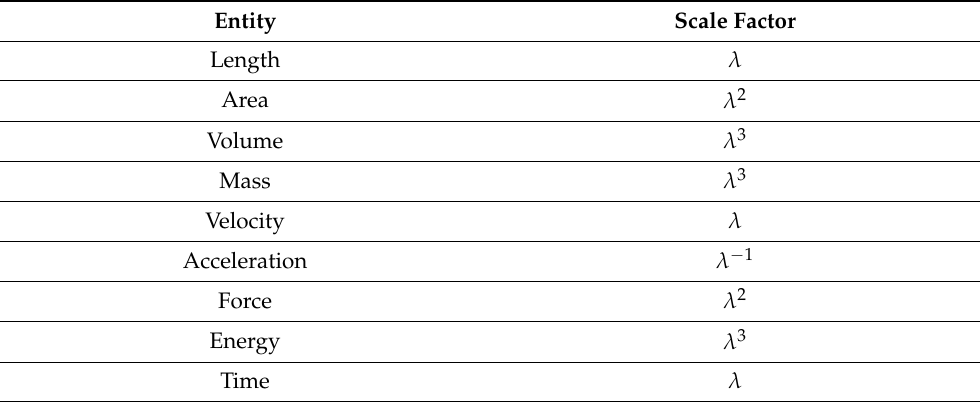
Table 3. Scaling factors of the system